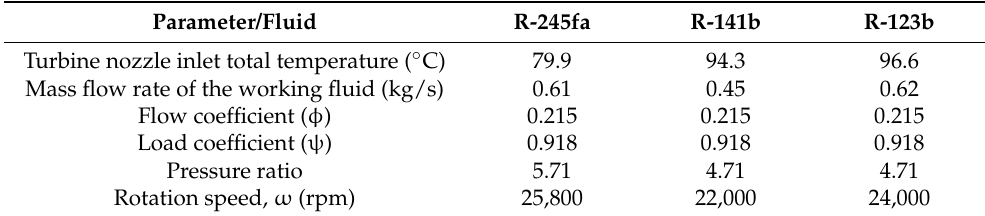
Table 3. Parameters of the radial turbine project.